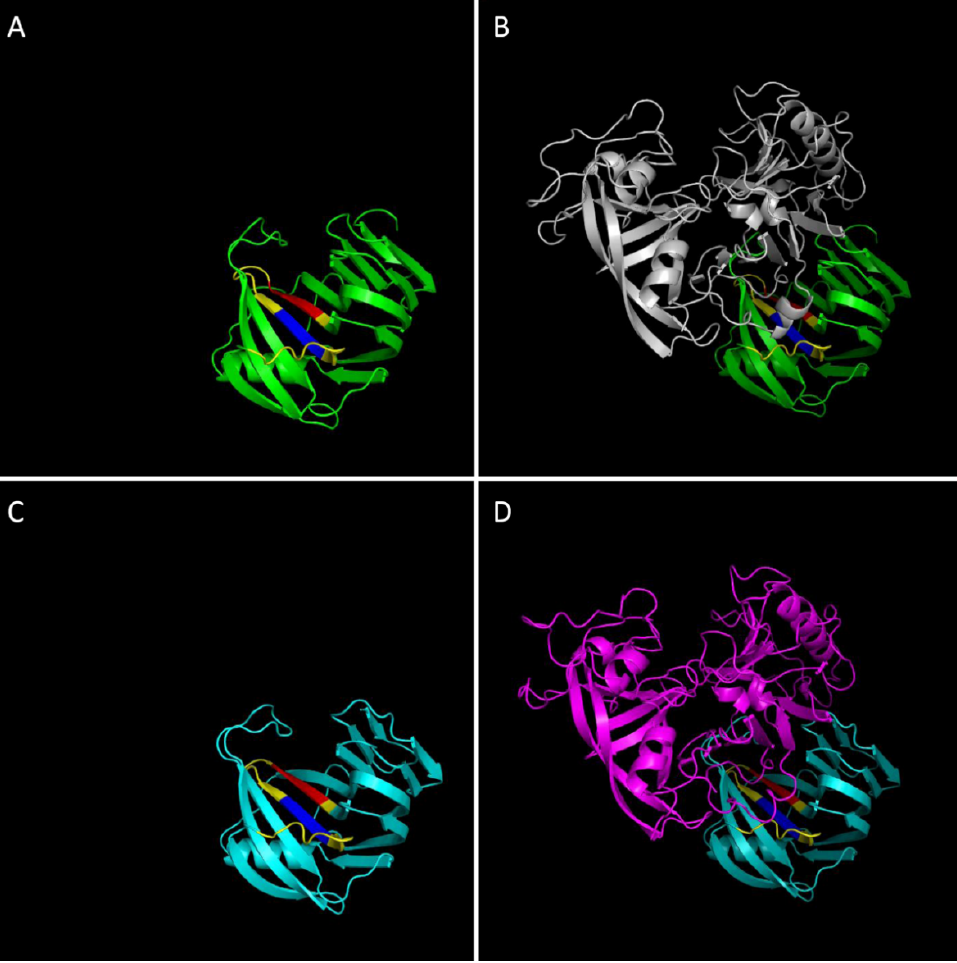
Figure 4. Molecular models of ( A ) B. cinerea xylanase BcXyn11a; ( B ) BcXyn11a interacting with TAXI-I; ( C ) F. graminearum xylanase FGSG_03634; ( D ) FGSG_03634 interacting with TAXI-III. Hypothetical three-dimensional complexes in B and D are based on the crystal structure (2B42) of TAXI-I in complex with B. subtilis xylanase A [75]. Models have been obtained by aligning a single protein structure to 2B42, used as structural templates, by PhMol software (The PyMOL Molecular Graphics System, Version 2.0 Schrödinger, LLC). Green: BcXyn11a. Grey: TAXI-I. Cyan: FGSG_03634. Magenta: TAXI-III. Yellow: 25 aa peptide identified in [90]. Red: M1 peptide (YGWT). Blue: M2 peptide